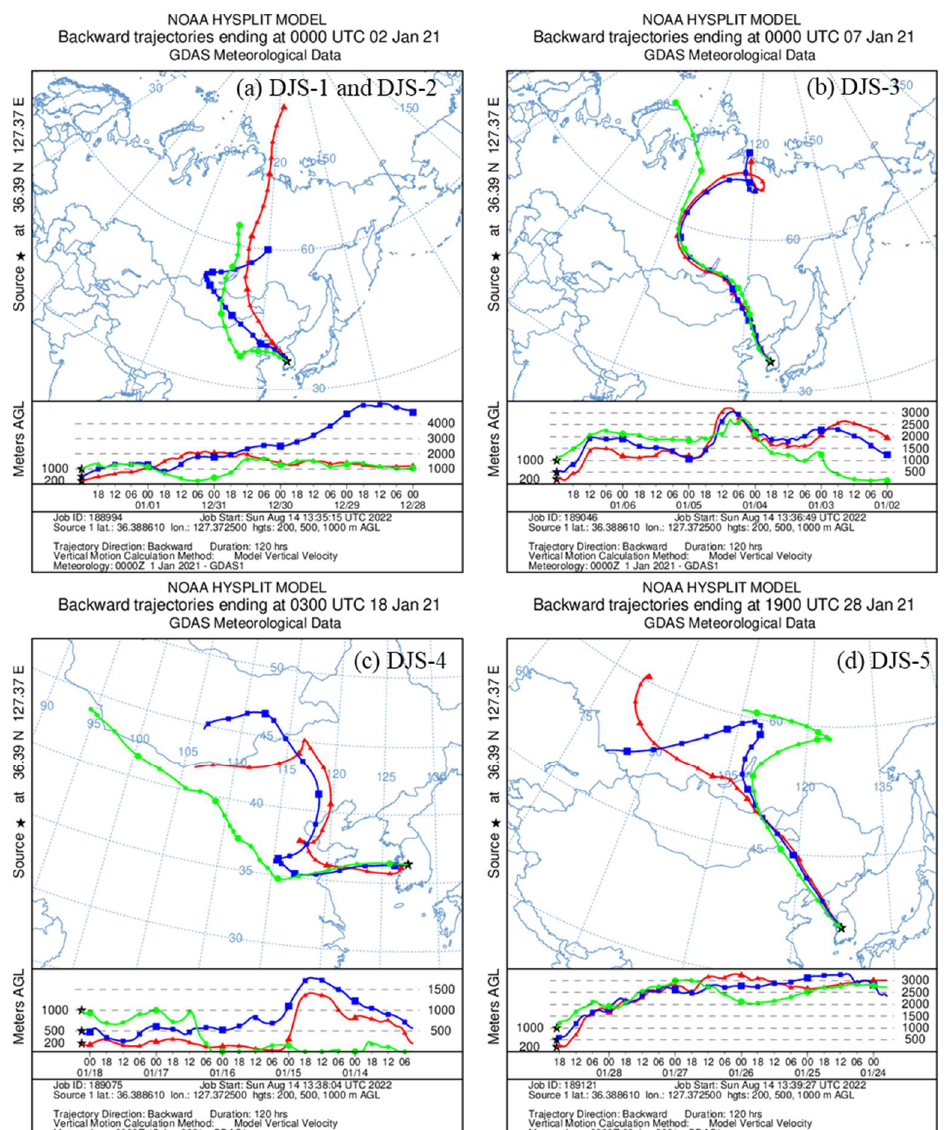
Figure 7. Five-day backward trajectories arriving during snowfall sample collection days at Daejeon, the Republic of Korea. The color lines indicate the arrival heights of the air mass trajectories: red, 200 m; blue, 500 m; and green, 600 m. ( a – d ) DJS-1 through DJS-5 are the snow sample IDs shown in Table 1. The color lines represent the different heights of the air mass backward trajectories: red, 200 m; blue, 500 m; and green, 1000 m.